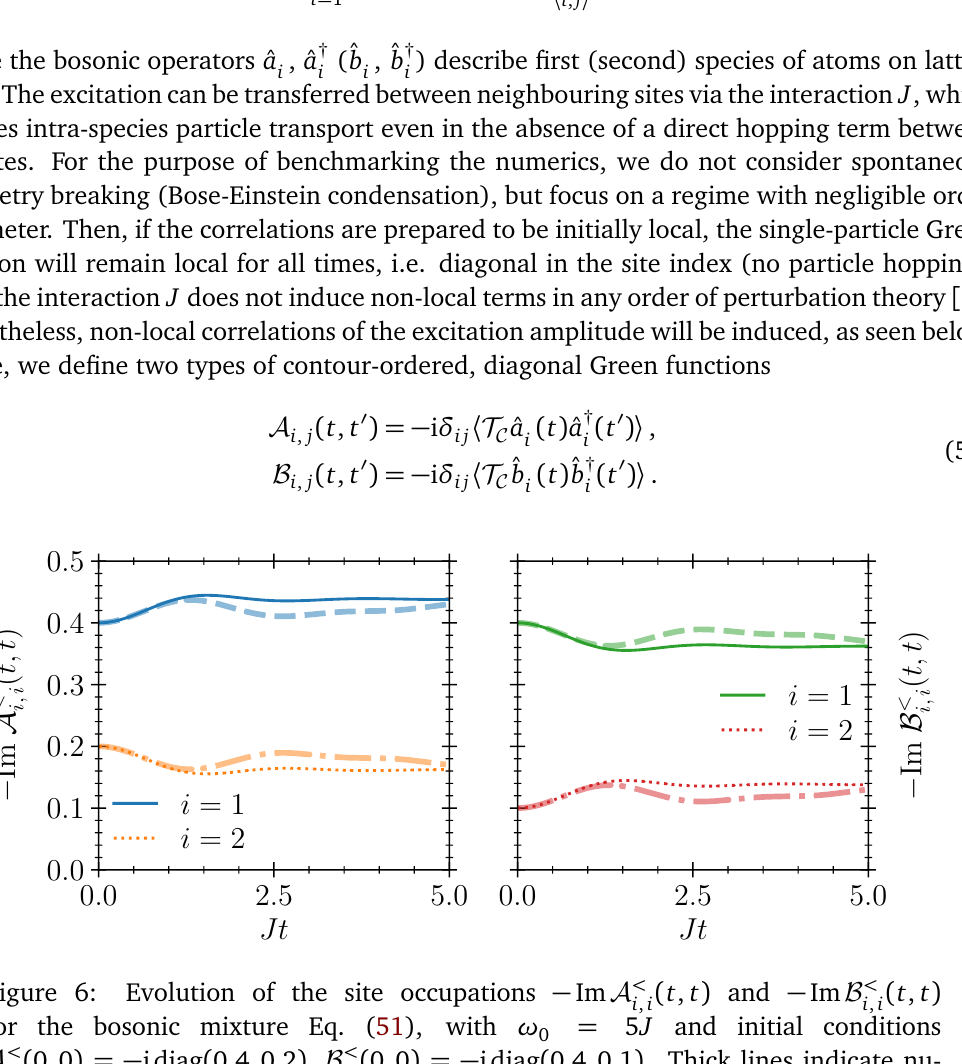
Figure 6: Evolution of the site occupations − Im for the bosonic mixture Eq. (51), with ω